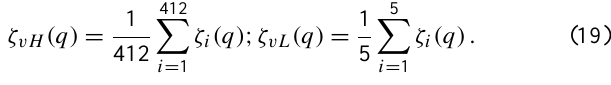
Fig. 4. The scaling of the structure functions of the wind speed S v (q) (a) for data sampled at 20Hz and (b) for data sampled at 1Hz. The structure functions display also two scaling regimes for 0 . 05 6 1t 6 10 3 s for data sampled at 20Hz and a scaling regime for 1 6 1t 6 5 × 10 5